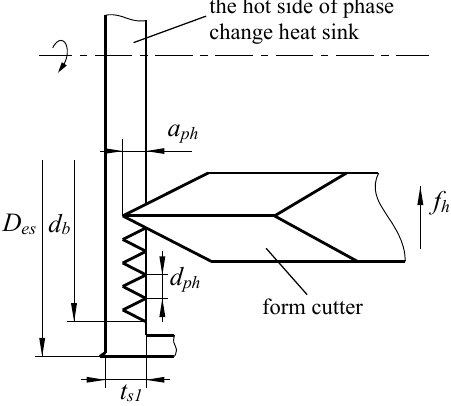
Figure 3. The schematic to form spiral grooves by P-E ploughing-extrusion processing.